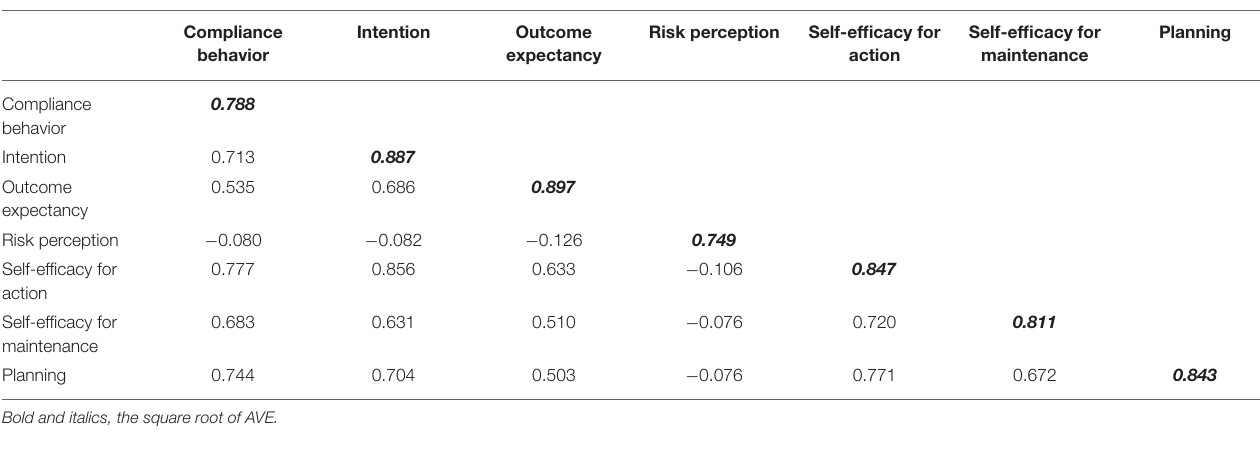
TABLE 5 | Discriminant validity- Fornell-Larcker criterion.